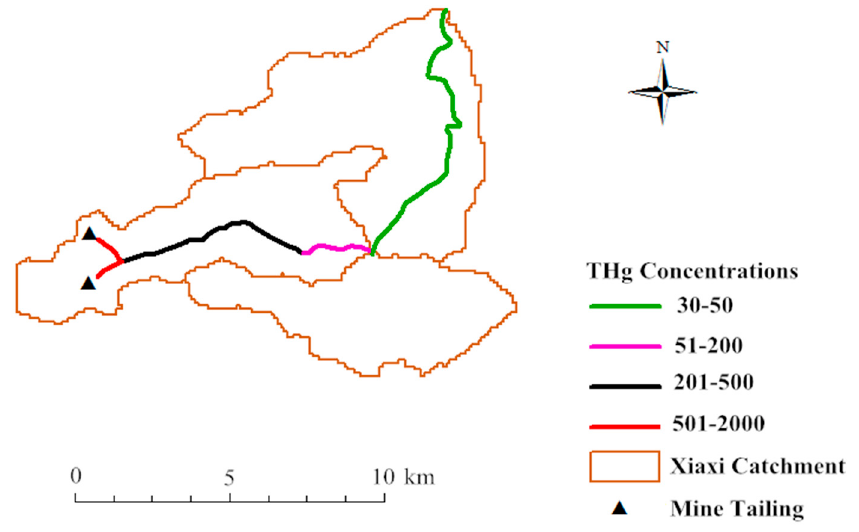
Figure 10. Spatial distribution of THg concentrations along the watercourse of Xiaxi River.